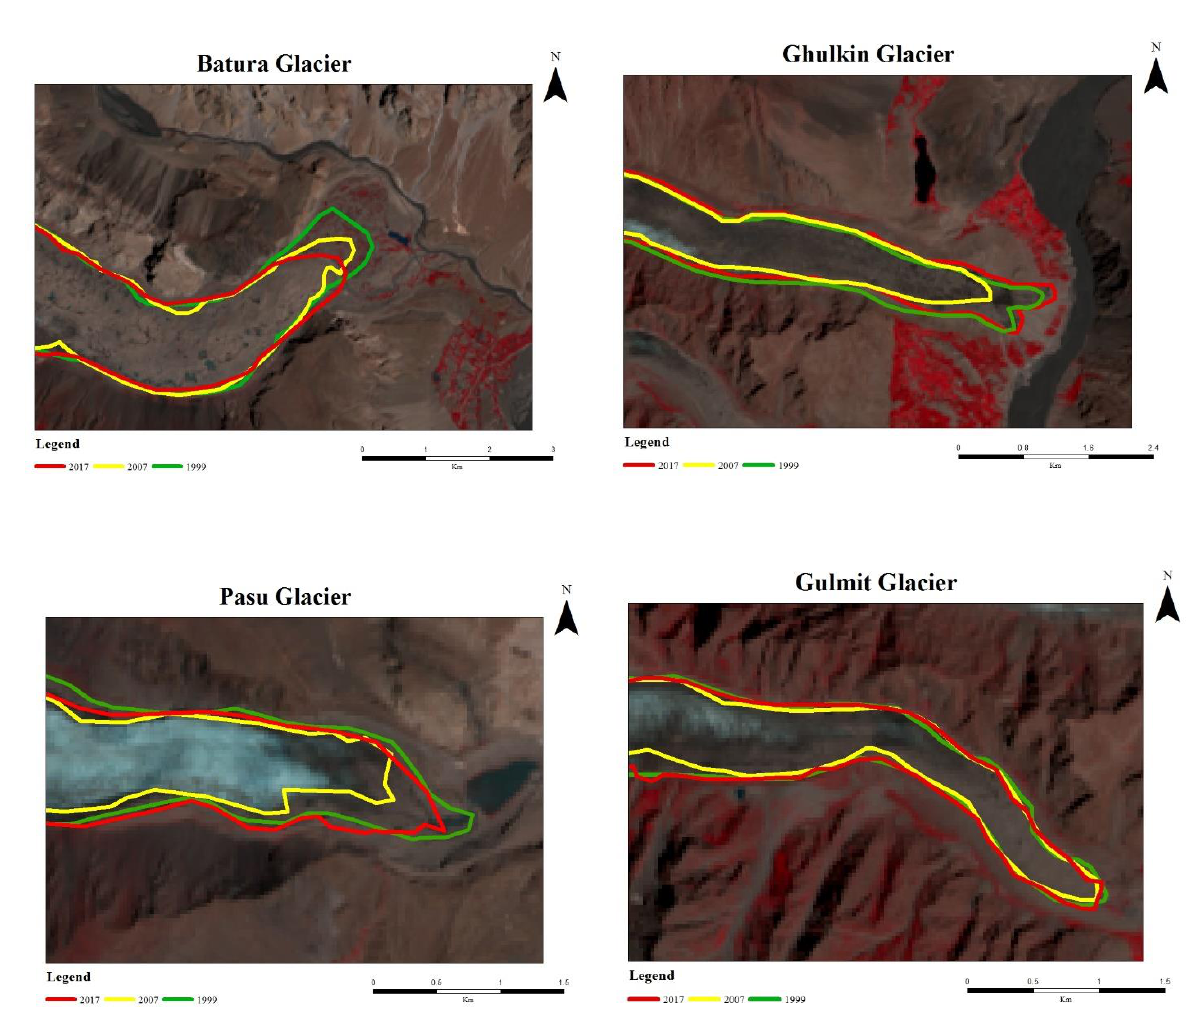
Figure 5: Terminus of